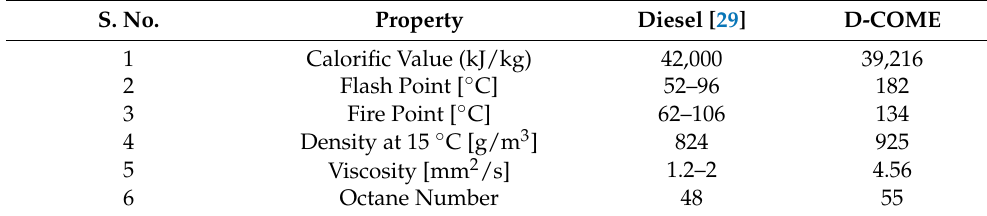
Table 1. Physical properties of commercial diesel and D-COME.